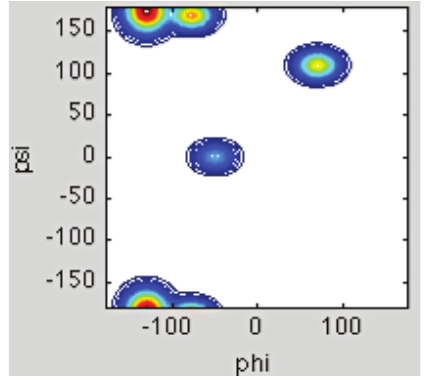
Figure 15. Conformation distribution of the central residue in unblocked GDG illustrating the high turn propensities of aspartic acid. Taken from [78] and modified.